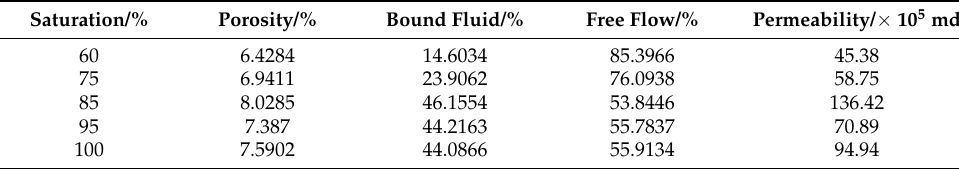
Table 3. NMR parameters of sandstone with different